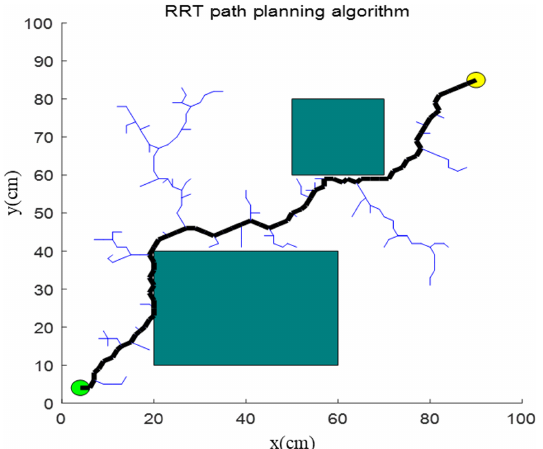
Figure 4. Schematic diagram of RRT algorithm searching in obsta- cle space.